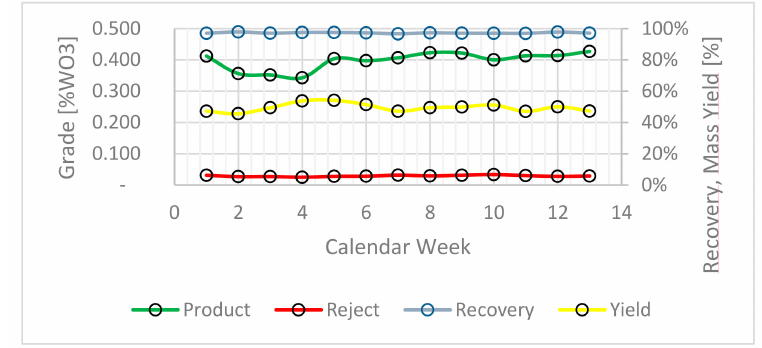
Figure 4. Process data from the waste rejection stage using XRT-based ore sorting